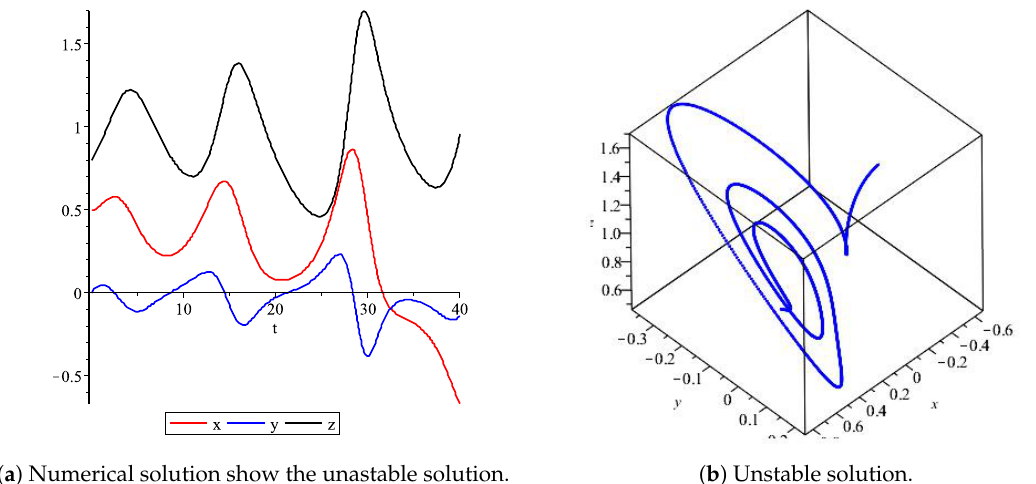
Figure 3. Solution for system Equation (6) when α = 0.95, β = 0.1827, σ =